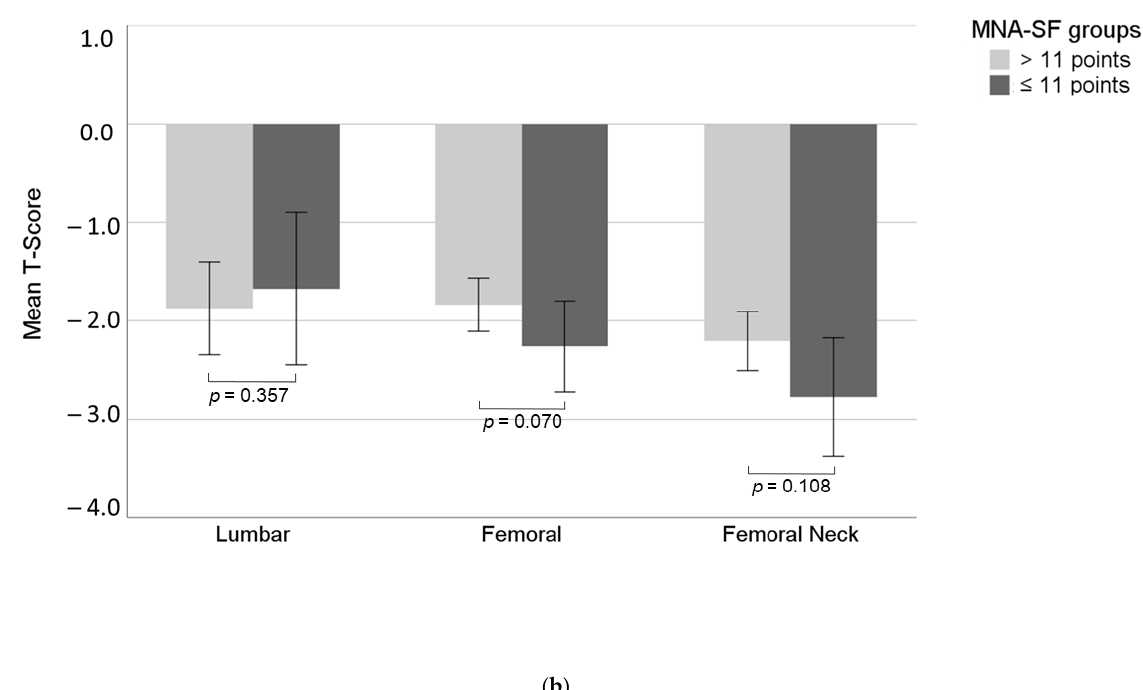
Figure 3. ( a,b ): differences between T-scores for different scores in MNA-SF and SARC-F questionnaires, respectively.